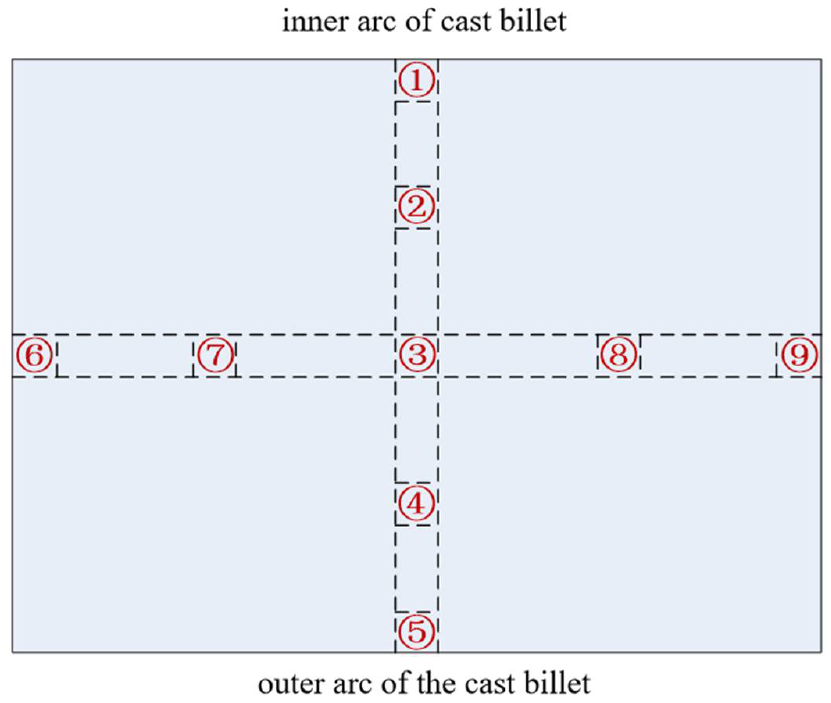
Figure 6. Sampling Figure 6. Sampling plan. Table 3. Non-metallic inclusions in billet before improvement.